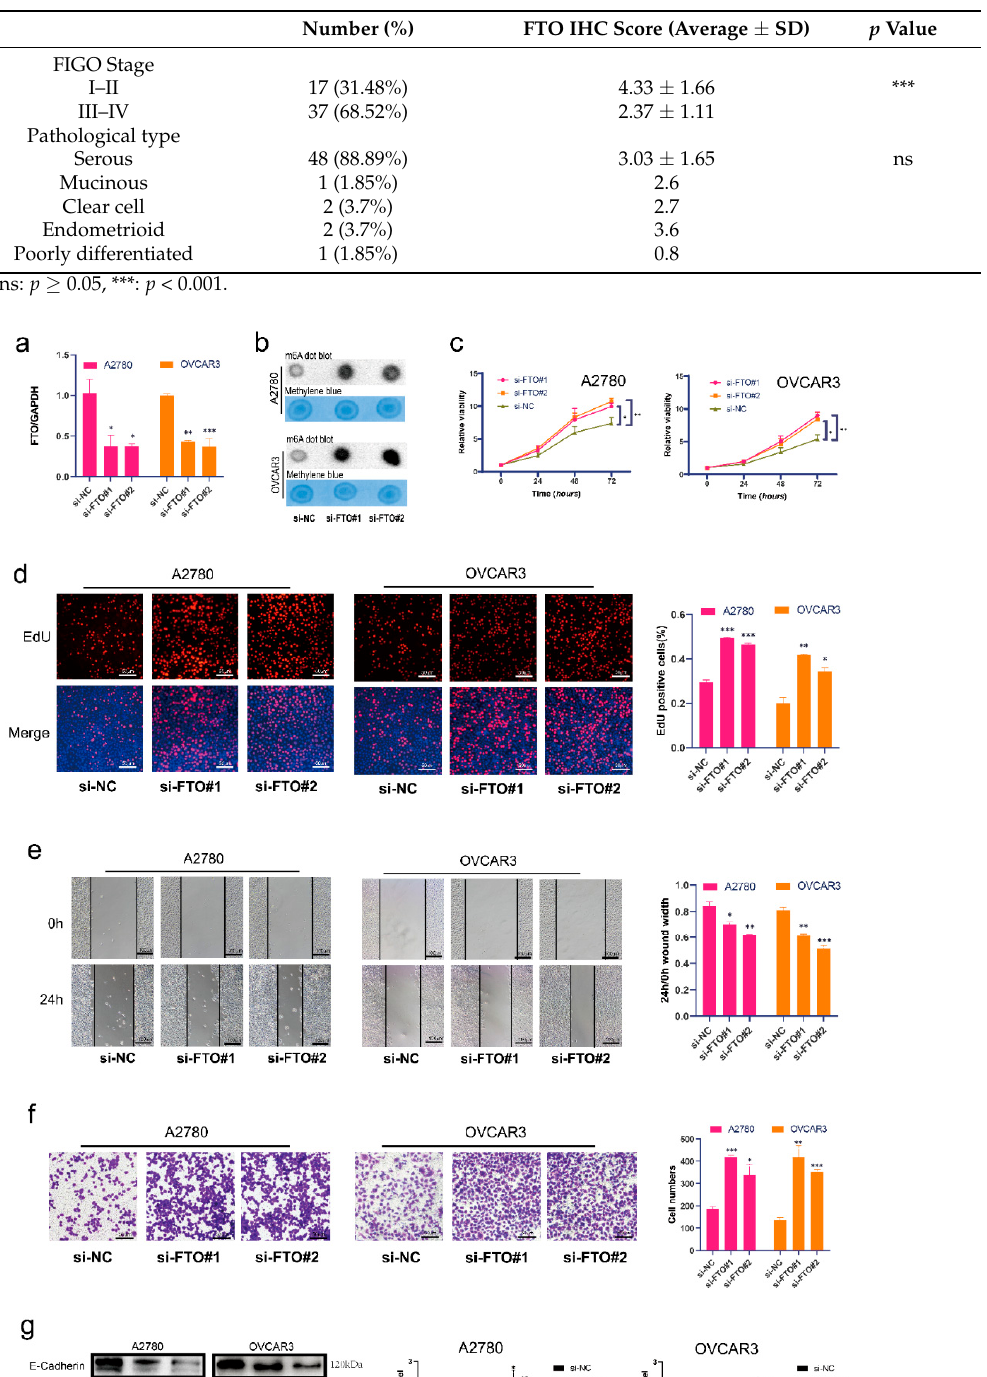
Table 1. Analysis of FTO expression combined with clinicopathological parameters in EOC.